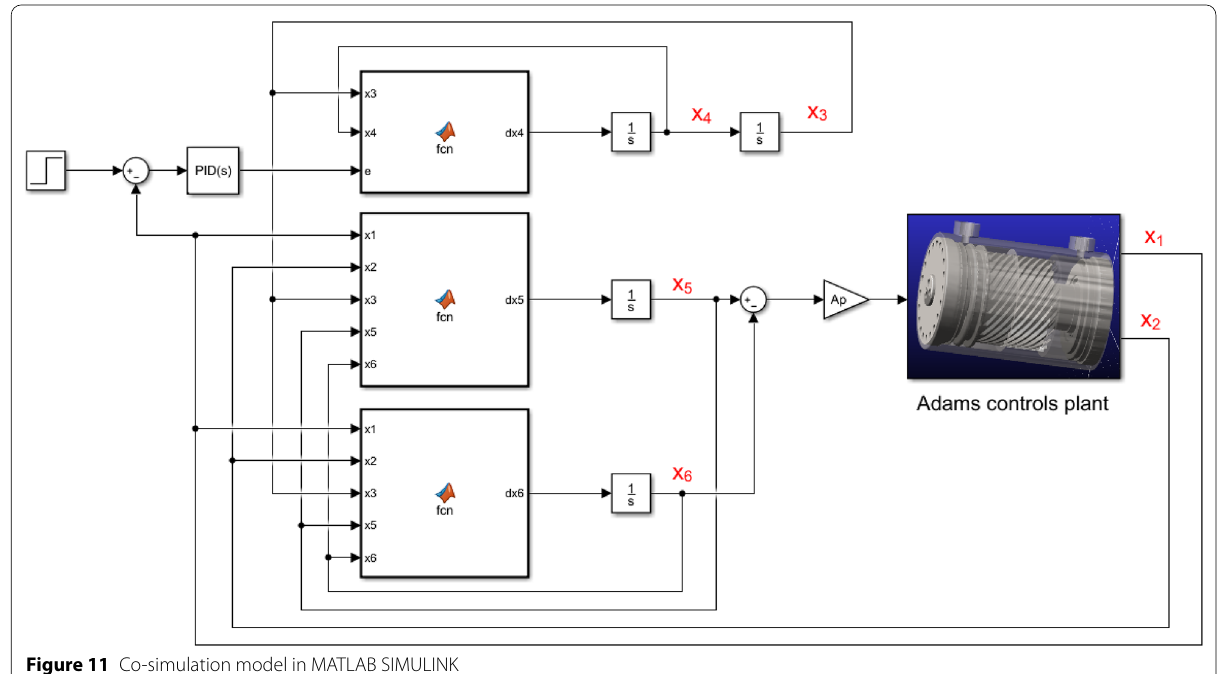
Figure 11 Co-simulation model in MATLAB